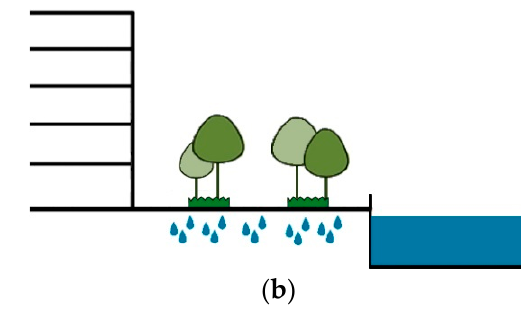
Figure 11. ( a ) NBS soft solution; ( b ) medium-hard.